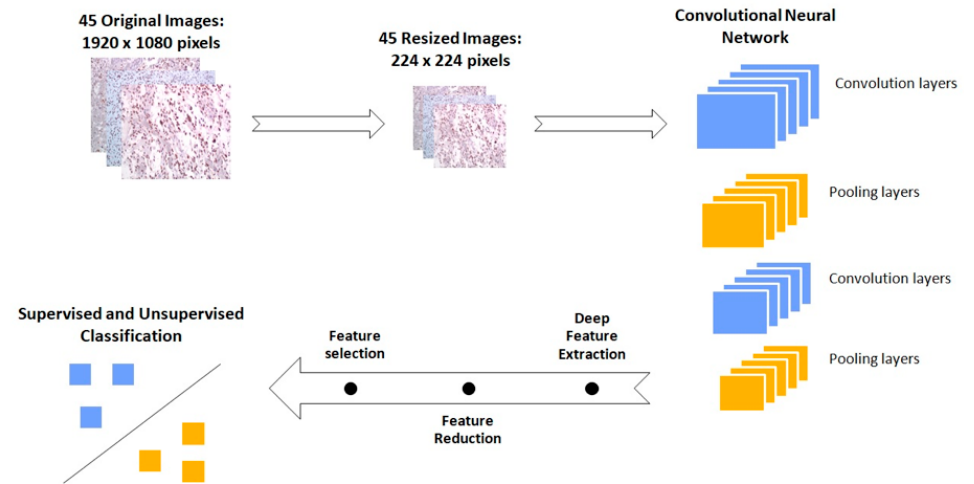
Figure 5. Schematic representation of the workflow followed for the discrimination of the immuno- histochemical (IHC) images between low- and high-risk biopsies. The initial images are resized in order to fit in the Vgg16 Convolutional Neural Network. This pretrained network performs the feature extraction. Subsequently the image features are processed in order to be classified from both supervised and unsupervised algorithms.